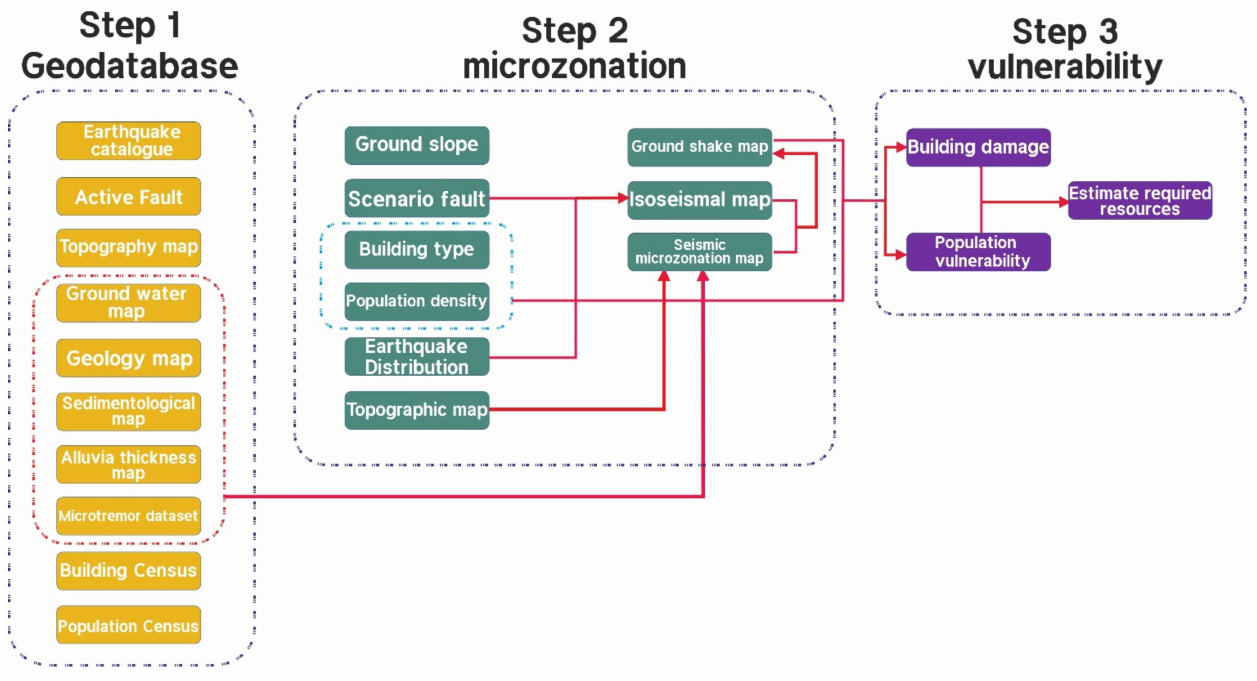
Figure 3. Flowchart of the 1721 and 1780 earthquake